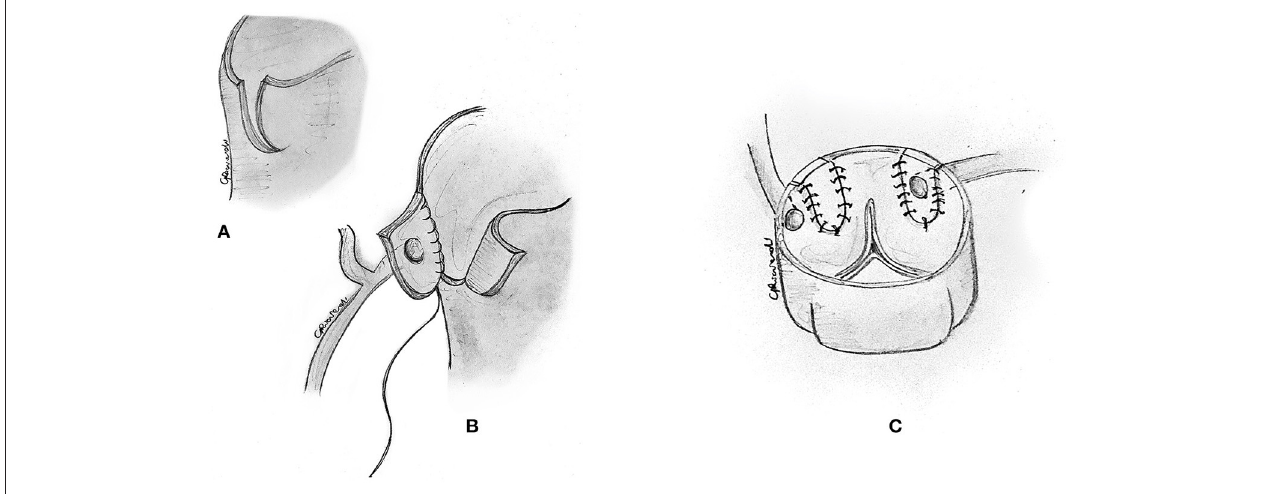
FIGURE 8 | Reimplantation technique. (A) Alternatively, a corresponding portion of the correct sinus is incised through a medial trap-door technique. (B) The coronary button is sutured to the aorta in its new position. (C) The original location of the ostium is usually closed with a small prosthetic patch to reconstruct the aortic wall.